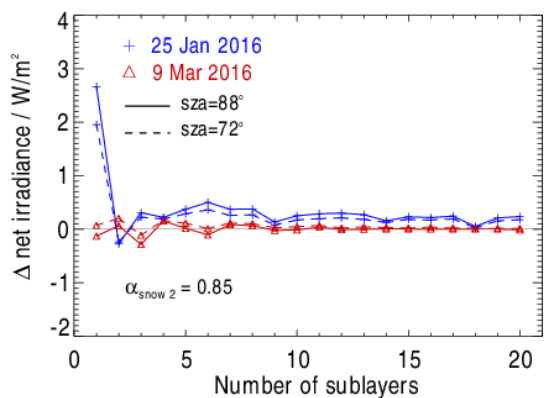
Figure 12. Differences between net irradiances ( F net , TOA ) calcu- lated for the measured IWC profile and IWC profiles with differ- ent vertical resolution. The x axis shows the number of layers into which the entire ice cloud is